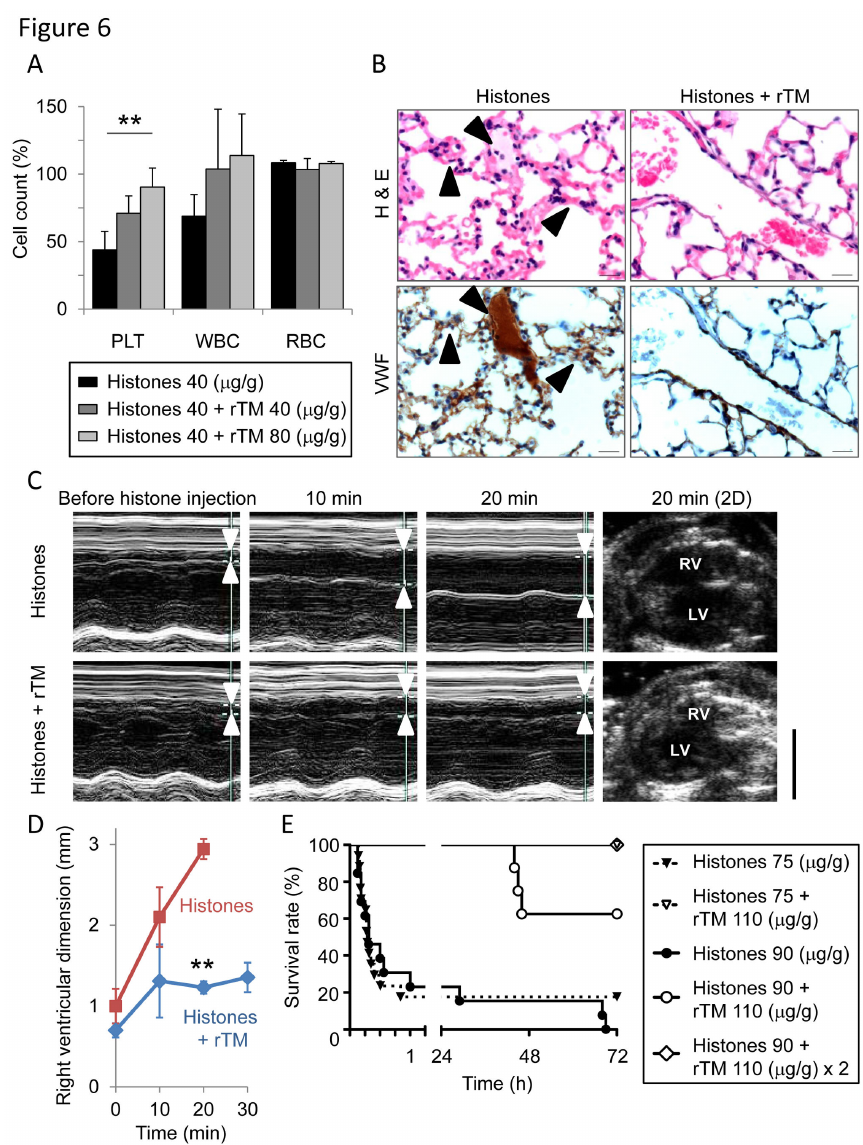
Figure 6. Recombinant thrombomodulin (rTM) protects mice against histone-induced fatal thrombosis. (A) The protective effect of rTM on histone-induced thrombocytopenia. Pretreatment with rTM (40 or 80 µg/g) 30 min before histone injection (40 µg/g) prevented histone-induced thrombocytopenia in mice (n = 3-4 per group, mean ± S.D.). ** P < 0.01 compared with the histone-alone group. (B) The protective effect of rTM on histone-induced VWF-rich thrombus formation. Arrowheads indicate intravascular thrombi. Pretreatment with rTM (110 µg/g) 30 min before histone injection (75 µg/g) suppressed histone-induced VWF-rich thrombus formation. Representative images of n = 5 (histone-alone) and n = 4 (histones + rTM). Scale bar = 20 µm. (C) The protective effect of rTM on histone-induced right-sided heart failure. Right ventricular diastolic dimension was measured before and 10, 20, and 30 minutes after histone injection using conventional M-mode echocardiography. Arrowheads indicate right ventricles. Pretreatment with rTM suppressed histone-induced dilatation of the right ventricle. RV: right ventricle. LV: left ventricle. Representative images of n = 4 are shown. Scale bar = 5 mm. (D) Quantitation of (C). Pretreatment with rTM (110 µg/g) 30 minutes before histone injection (75 µg/g) suppressed histone-induced dilatation of the right ventricle. The data of histone-alone group in 30 minutes are lacking because none of the mice in this group survived for up to 30 minutes after histone injection. ** P < 0.01 compared with the histone-alone group. (E) The protective effect of rTM on histone-induced lethality. Mice were treated with a single injection of 110 µg/g of rTM 30 minutes before histone injection (75 or 90 µg/g) or double injection of 110 µg/g of rTM 30 minutes before and 90 minutes after histone injection (90 µg/g). rTM therapy significantly improved survival of histone-injected mice (n = 8-21 per group, P < 0.01 compared with mice injected with histone alone). doi: 10.1371/journal.pone.0075961.g006 PLOS ONE |